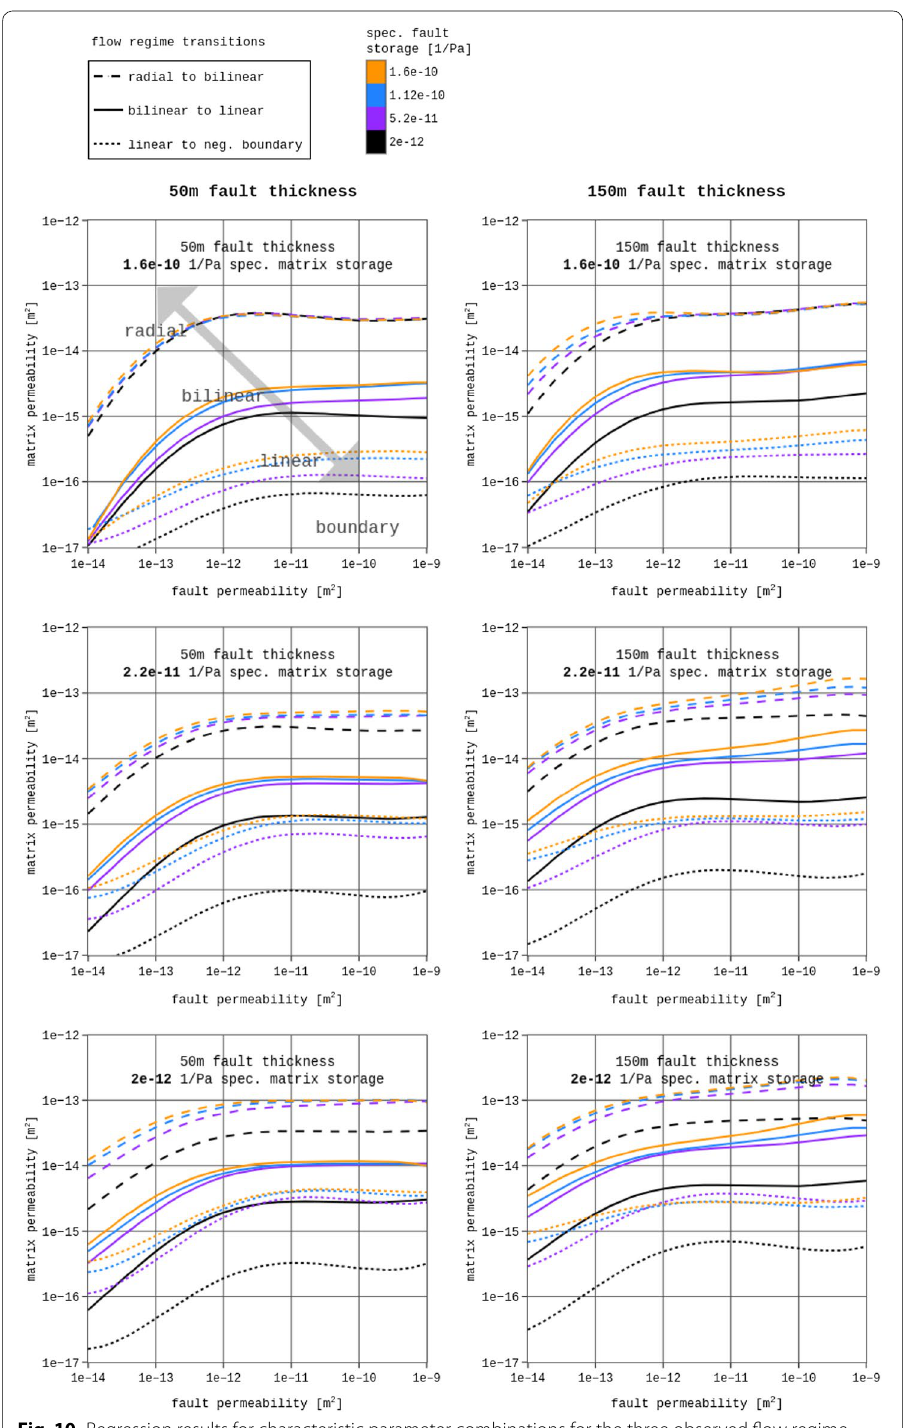
Fig. 10 Regression results for characteristic parameter combinations for the three observed flow regime transitions (1: radial to bilinear, 2: bilinear to linear, 3: linear to negative boundary); left: 50 m fault zone thickness; right: 150 m fault zone thickness; subplots have fixed specific matrix storage values; specific fault zone storage color-coded; line styles represent the flow regime transitions; parameter combinations that fall on the transition line should be seen as combinations for which the flow regime above has still been